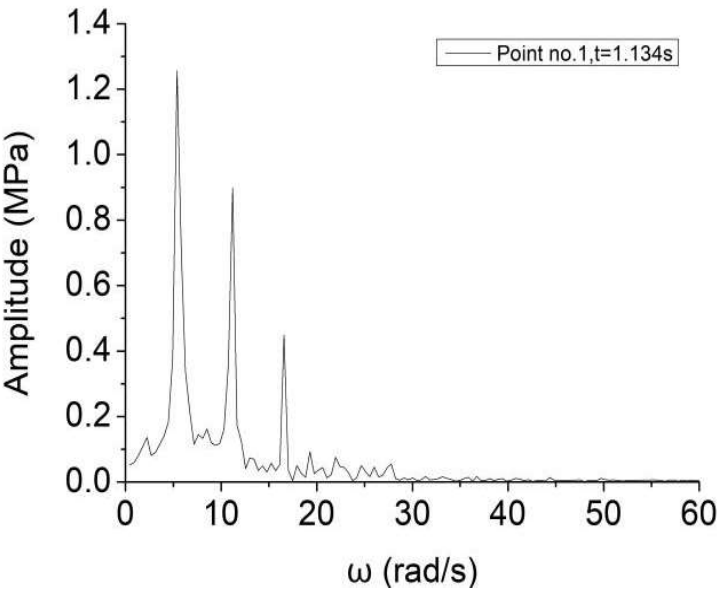
Figure 10. Stress amplitude spectrum of case 1.